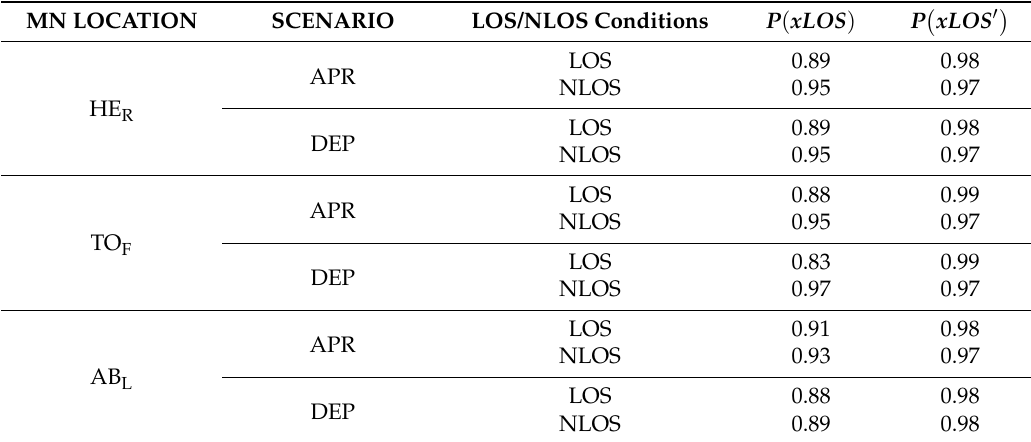
Table 3. The probability of the correct detection of the direct visibility